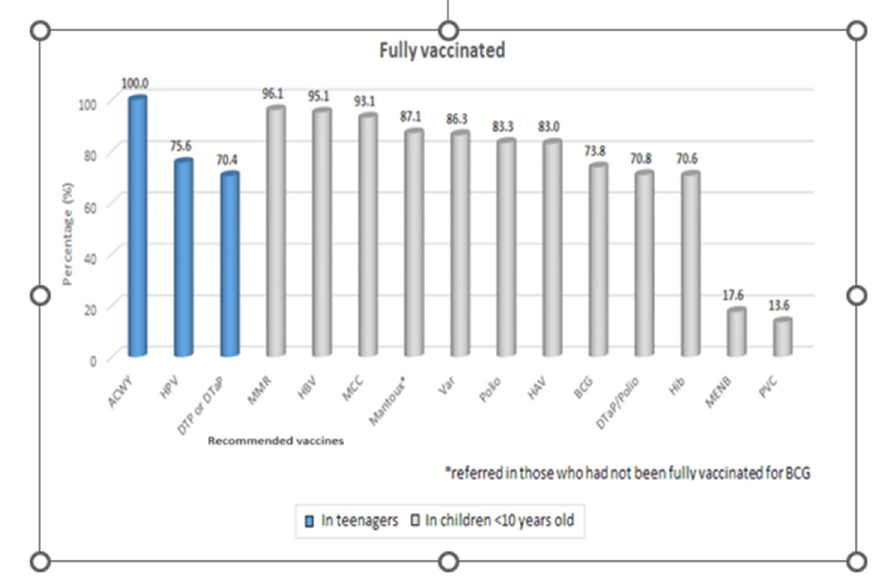
Figure 1. Percentages of being appropriately vaccinated in each vaccine.